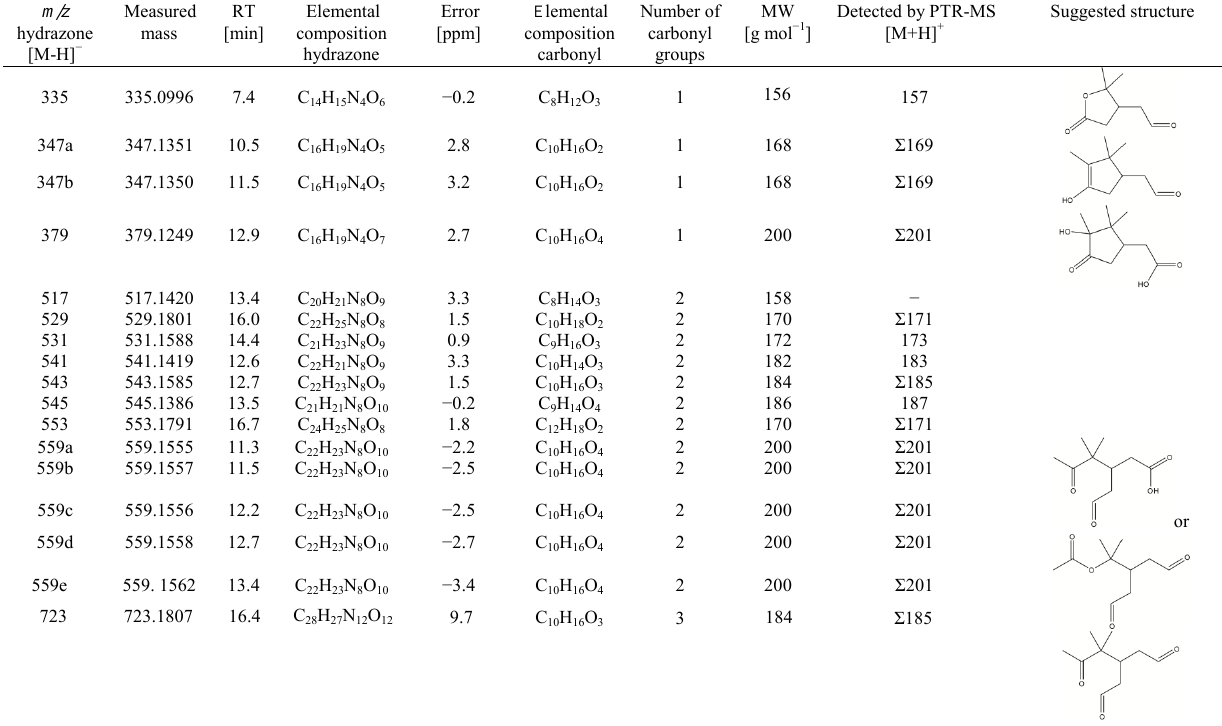
Table 3. Detected gas-phase compounds in the campholenic aldehyde ozonolysis using DNPH derivatisation and parallel PTR-MS measure-